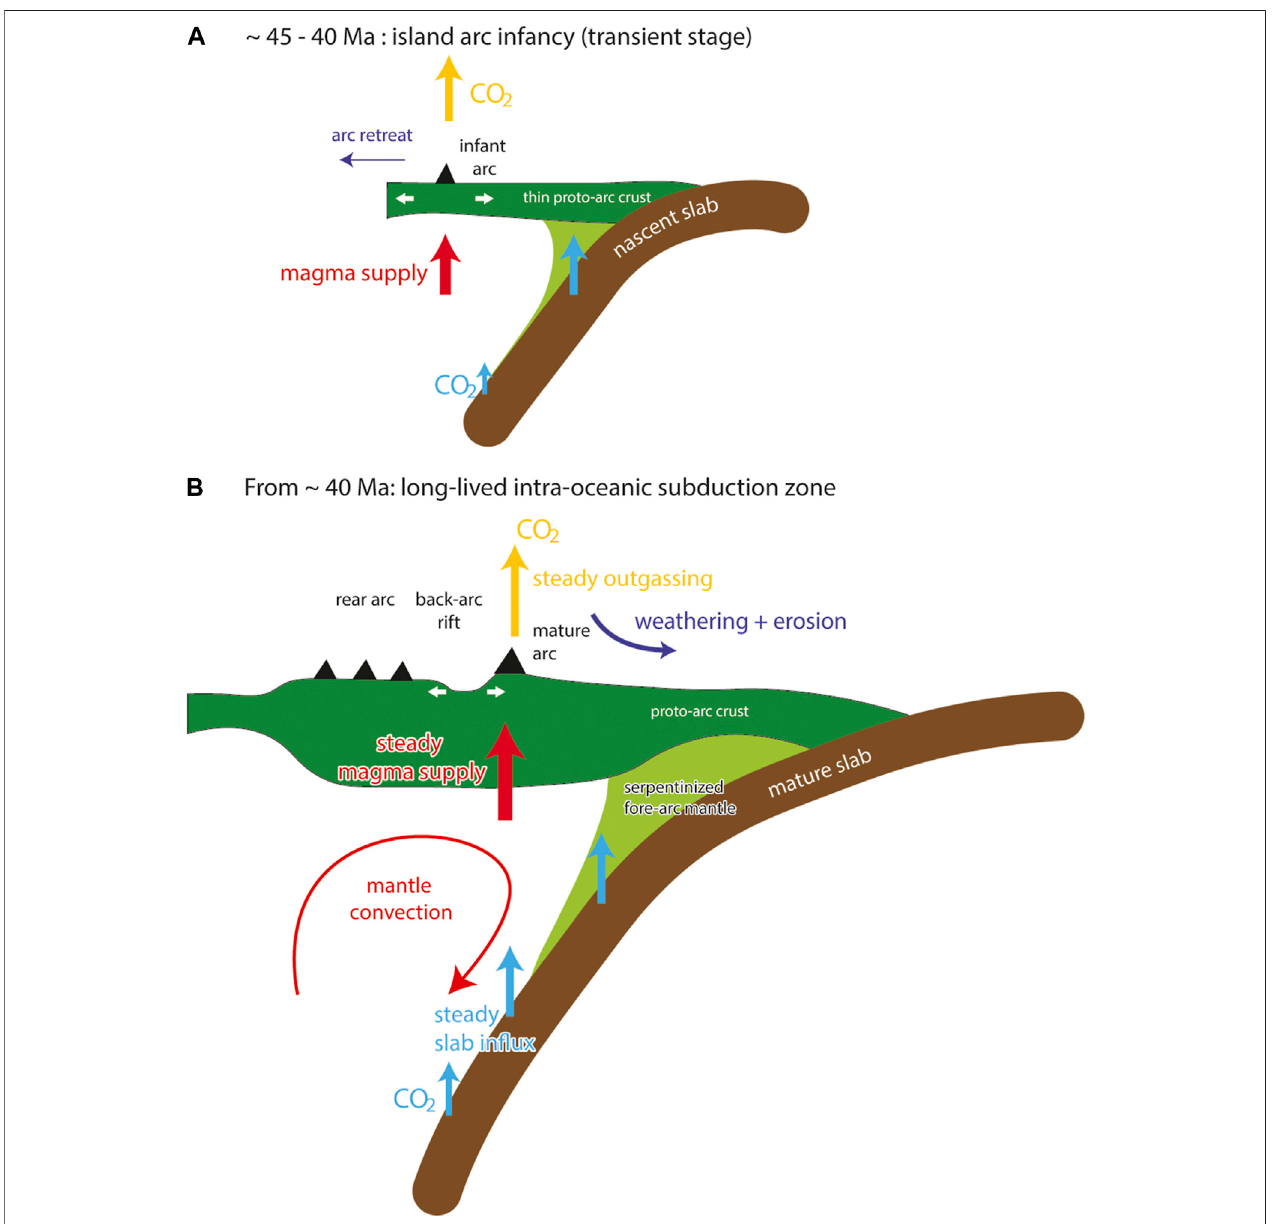
FIGURE12| SketchofcarboncycleoverthelifetimeoftheIzuintra-oceanicarc. (A) From~45 – 40 Ma,theinfantIzuarcrapidlydeveloped.Thevolcanicarcfrontis progressivelydisplacedawayfromthetrenchuntilreachingitscurrentlocation.Duringthattransientstage,thesteadystateisnotmaintained. (B) TheIzuarchasreached maturity ~40 Ma ago and maintains its current location at ~ 150 km from the Izu Trench. The serpentinized fore-arc mantle developed and cools the shallow part of the slab top. The subduction zone is in a quasi steady state and maintains self-sustained conditions over long time periods. During that stage, volcanic degassing of CO 2 is readily balanced by silicate weathering and tectonic erosion within 100 – 300 kyr.